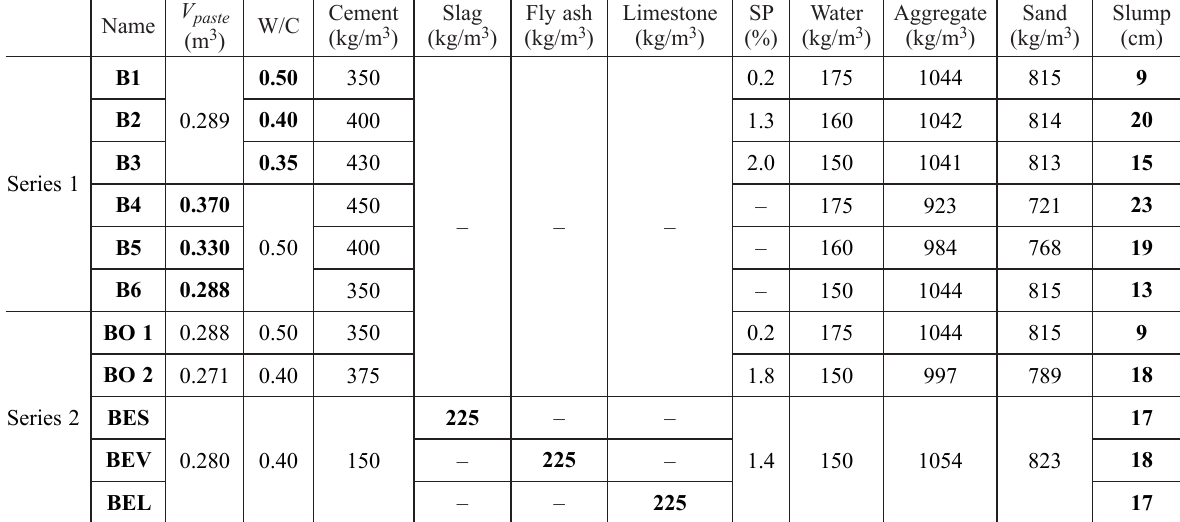
Table 1. Concrete mixture